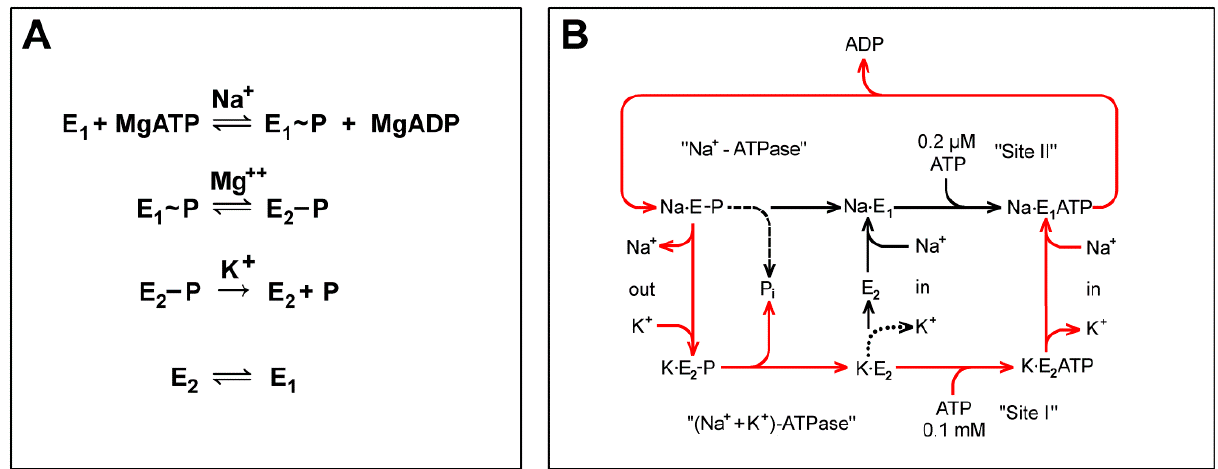
Figure 1. First representation of the pump cycle of the Na,K-ATPase. A: Reaction cycle of the enzyme activity with the ion substrates need- ed to enable the respective reaction step, published in 1967 by Albers and collaborators. 7 B: Reaction cycle with merged enzyme and trans- port functions, the so-called Post-Albers cycle, introduced 1972 by Post and collaborators. 8 The cycle marked in red represents the physi- ological